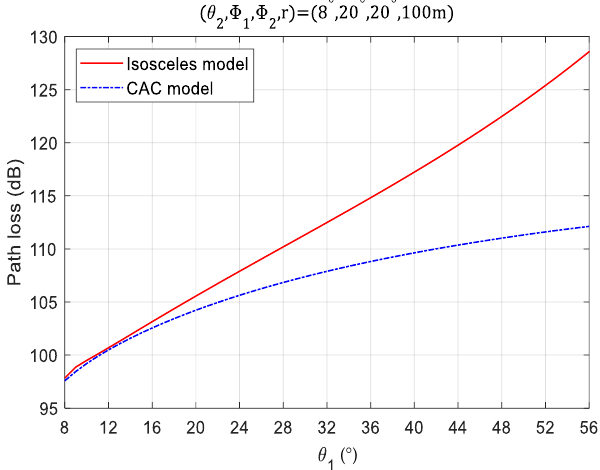
Figure 3. Relationship between path loss and transmit elevation angle.